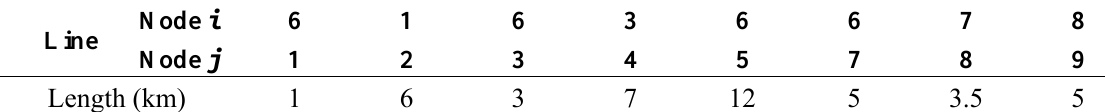
Table 2. Line lengths.